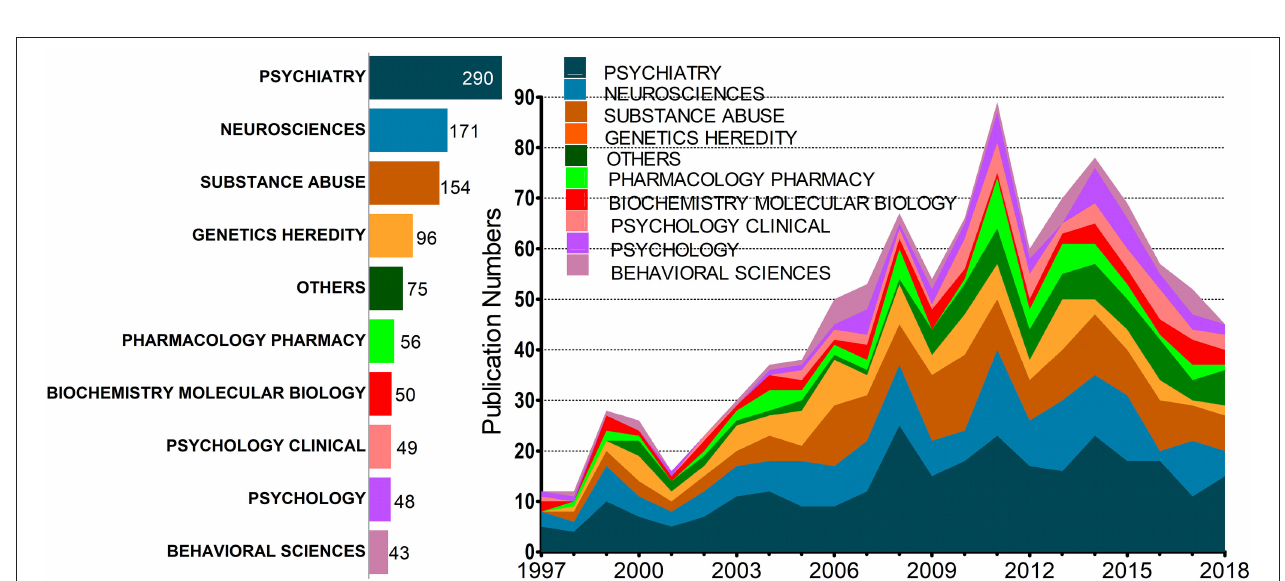
FIGURE 2 | Distribution of the annual number of substance-related disorders publications from 1997 to 2018; publications of different subjects are characterized by colors.